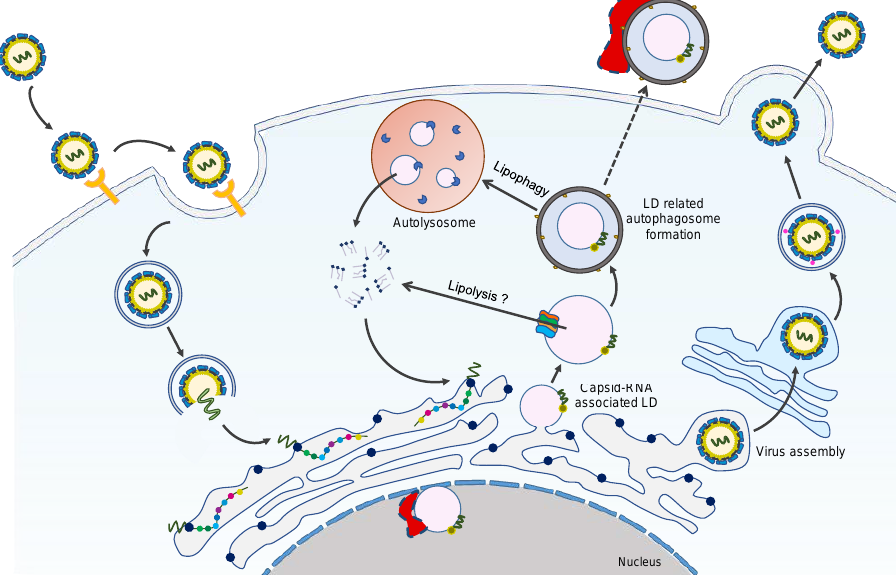
Figure 4. Overview of LDs-C protein interaction during the ZIKV life cycle. ZIKV infection promotes LDs formation at the early stages of infection. With the increasing interaction of LDs with ZIKV-C protein, lipophagy is induced to generate sufficient free fatty acids for robust viral replication and/or assembly. During this process, ZIKV NS4A/4B proteins may also contribute to the occurrence of lipophagy. We hypothesize that the eLDs and nLDs are involved in the ZIKV life cycle, and their formation and function possibly need the help of some unknown host factors, which are shown as red irregular polygons with a border of dashed lines.